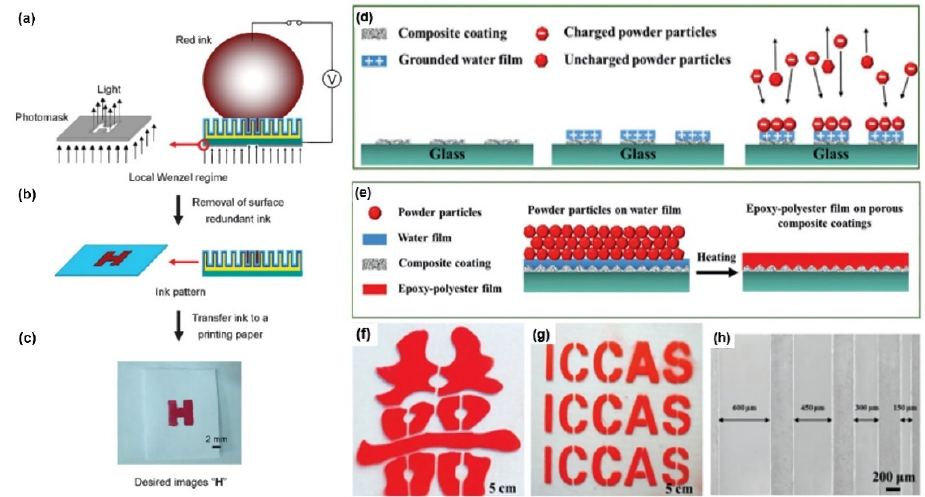
Figure 4. Liquid-patterned printing by TiO 2 and its superwettability. ( a ) Red ink was printed on the composite TiO 2 nanorod-array surface with illumination through the photomask. ( b ) After the illumination and voltage were turned off, an ink-patterned “H” was shown with the removal of the ink. ( c ) When the pattern is transferred onto the paper, the desired image “H” is obtained. Reprint from [34]. Copyright (2009), with permission from WILEY-VCH, Weinheim, Germany. ( d ) Process of the electrostatic attraction-induced patterning on the glass by spraying droplets on the glass patterned with a superhydrophilic nanoparticle (NP) coating. Electrostatic powder was adsorbed on the water film. ( e ) After heating for 20 min, a patterned film formed on the glass. ( f ) The pattern of the “Red Double Happiness”. ( g ) The pattern of “ICCAS”. ( h ) SEM image shows the patterned glass with different sizes of micro-grade lines. Reprint from [57]. Copyright (2016), with permission from WILEY-VCH, Weinheim,